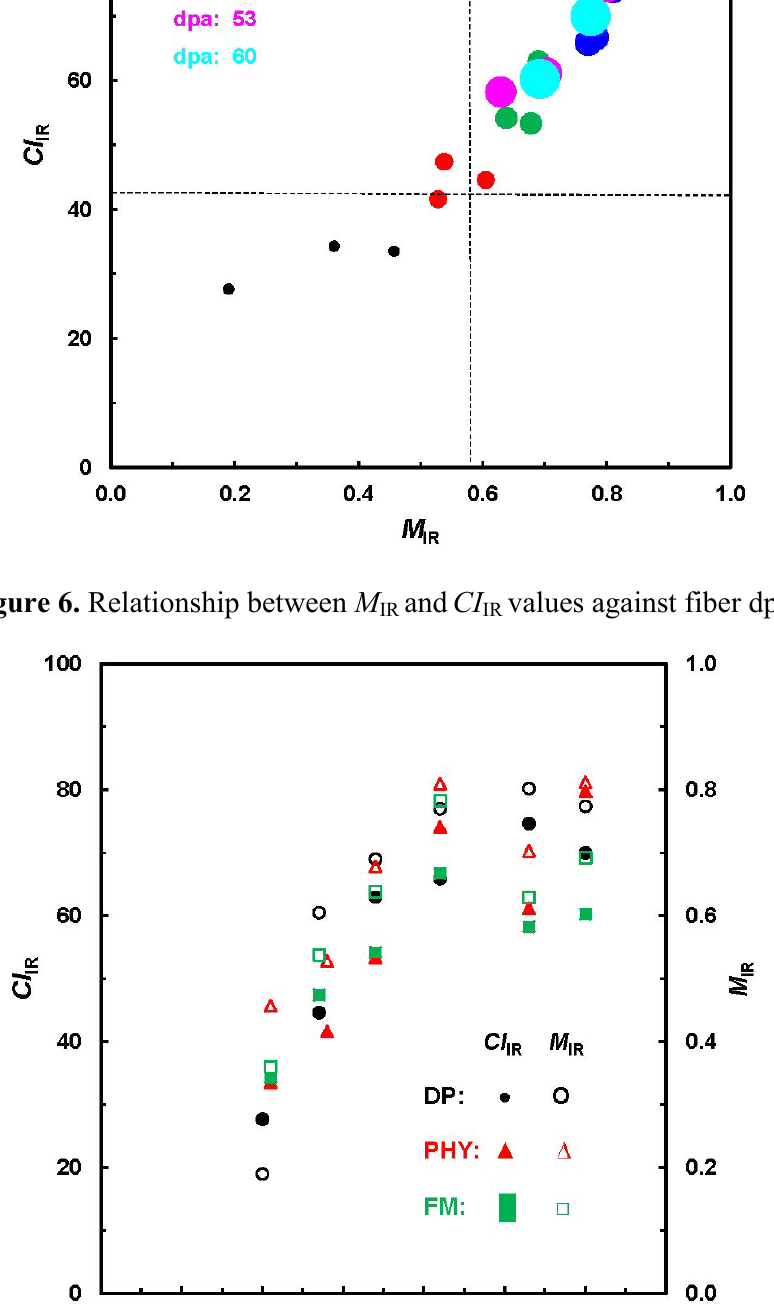
Figure 5. Relationship of M